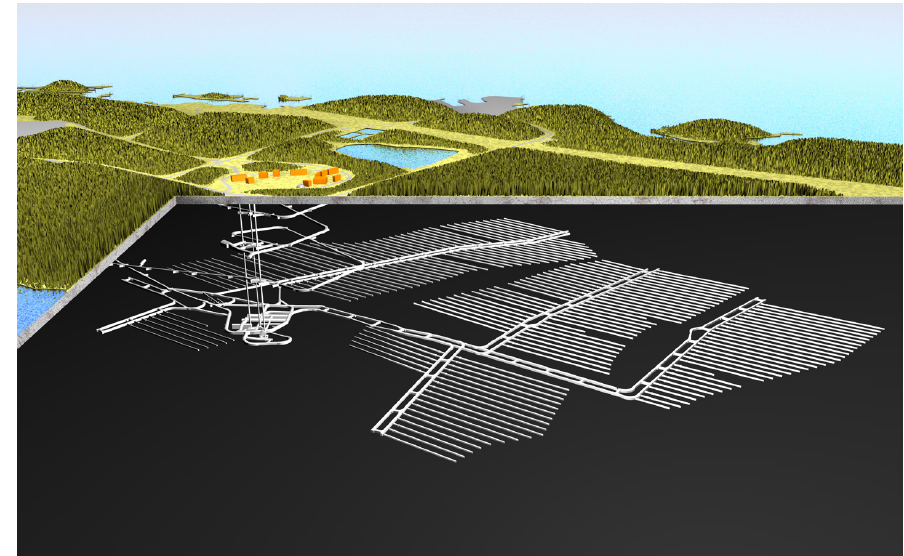
Figure 3. The schematic layout of the disposal facility—Posiva Oy